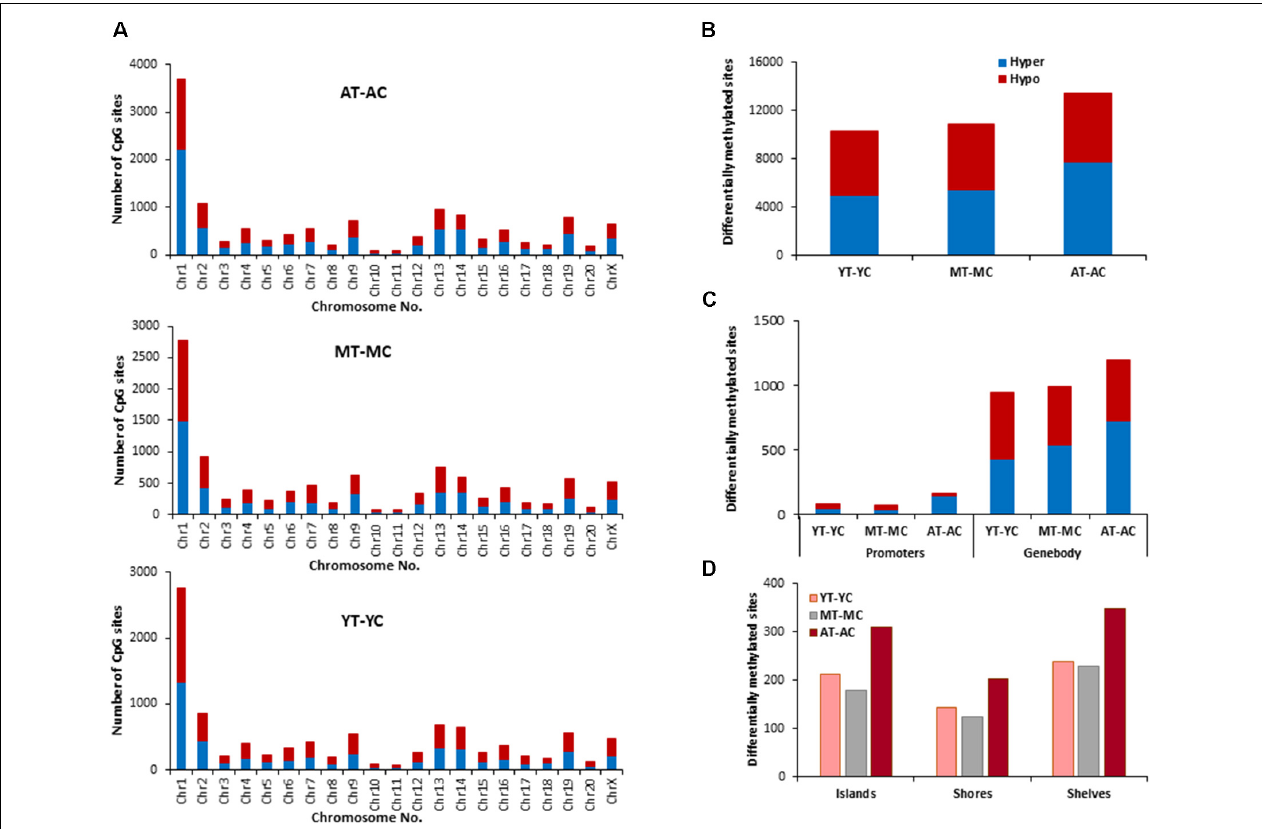
FIGURE 3 | Age-related differences in DNA CpG methylation due to E2-treatment. (A) Differentially methylated CpG sites along the chromosome (1–20) including X-chromosome for each age. The differential methylation was based on a statistical significance of p < 0.01. (B) Total number of differentially methylated CpG sites induced by E2-treatment for each age group. The red bars denote hypomethylation and blue bar denotes hypermethylation for the E2-treatment group relative to the age-matched control group. (C) Number of differentially methylated CpG sites in promoter and gene body regions in E2-treated relative to age-matched controls. (D) Comparison of the differentially methylated CpG sites across the regulatory regions: islands, shores, and